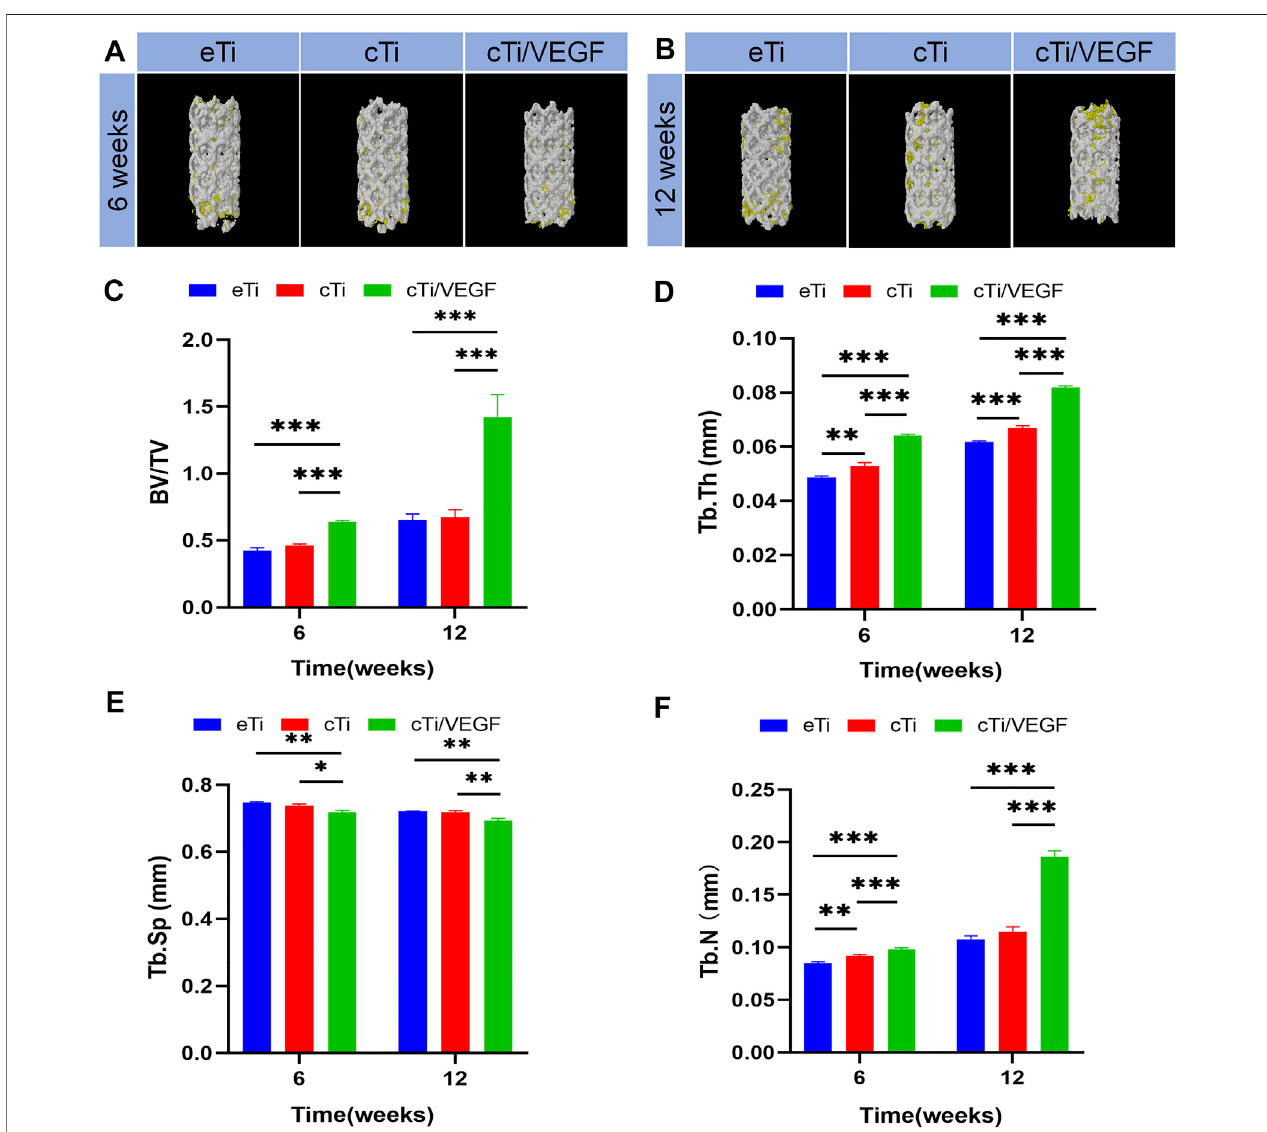
FIGURE 5 | Representative 3D reconstruction images of scaffold implantation in each group at 6 (A) and 12 (B) weeks after operation (yellow: bone tissue; white: scaffolds). Micro-CT image analysis of BV/TV (C) , Tb.Th (D) , Tb. Sp (E) , and Tb.N (F) in each group (n (cid:1) 3).